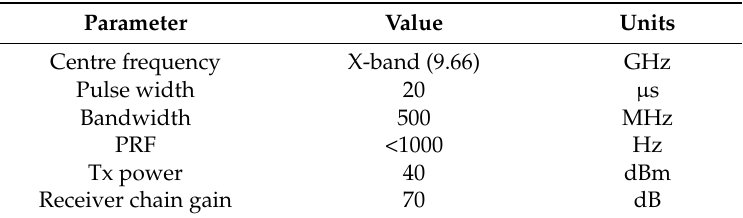
Table 1. System specification.